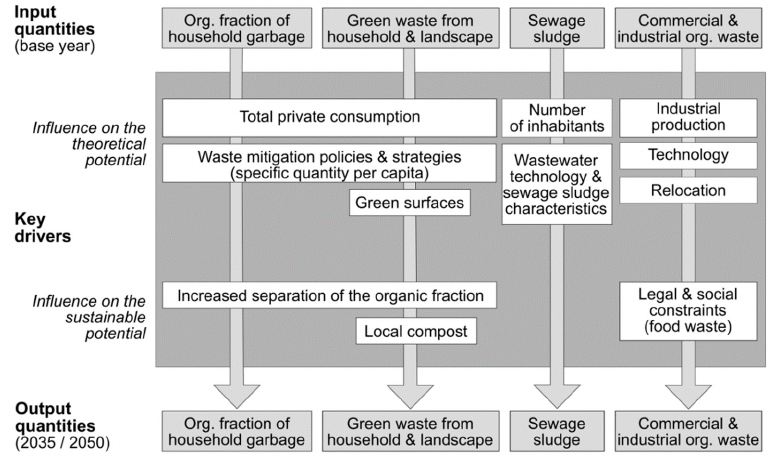
Figure 2. Key drivers for anthropogenic wastes (organic fraction of household garbage, green waste from households and landscape, commercial and industrial organic waste, and sewage sludge).